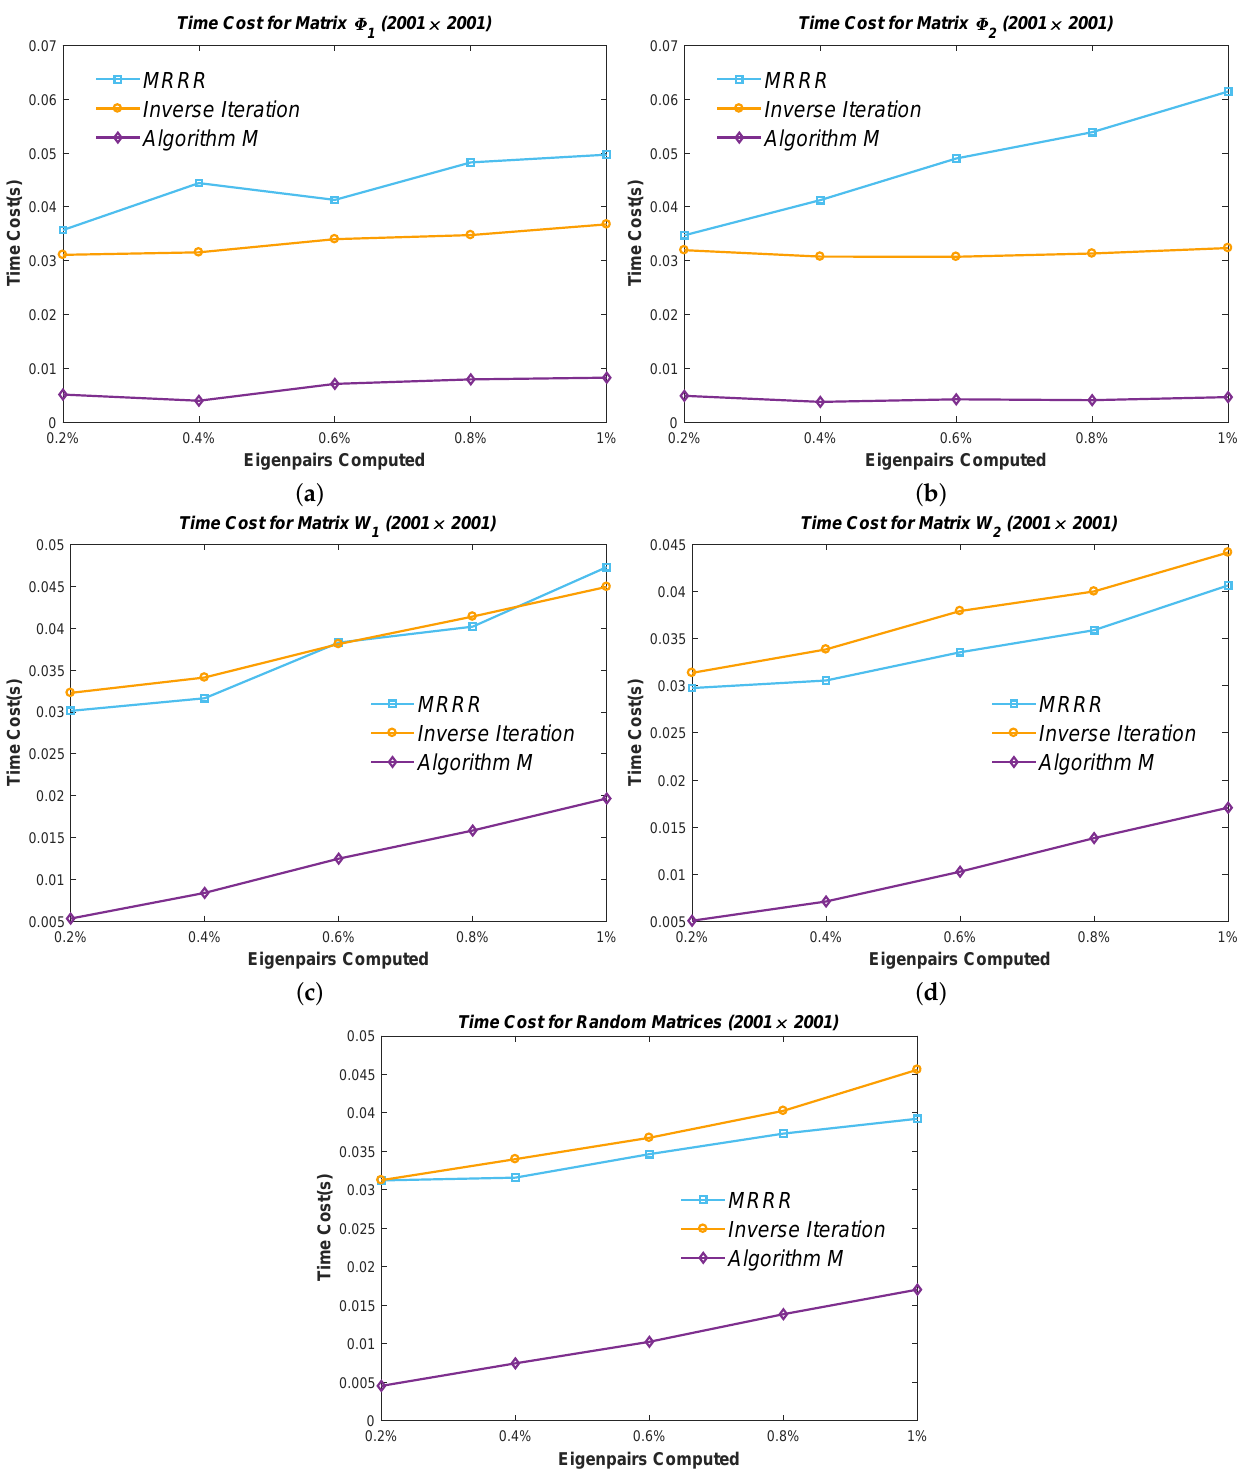
Figure 15. The time cost for minor eigenpairs in 2001 W 1 ; ( d ) Matrix W 2 ; ( e ) Random